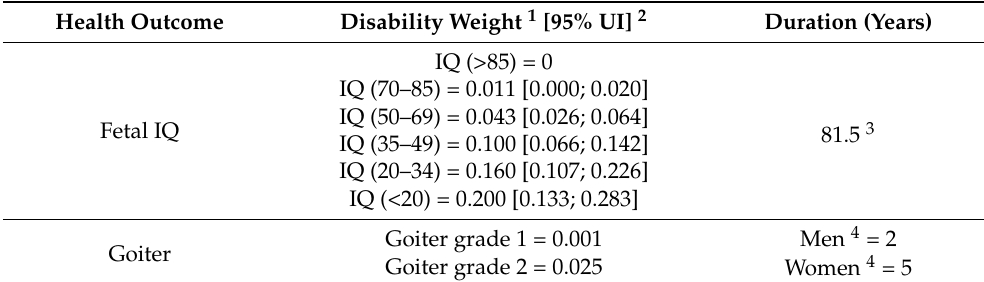
Table 2. Parameters used to estimate DALY for each of the health outcomes included in the risk– benefit assessment.